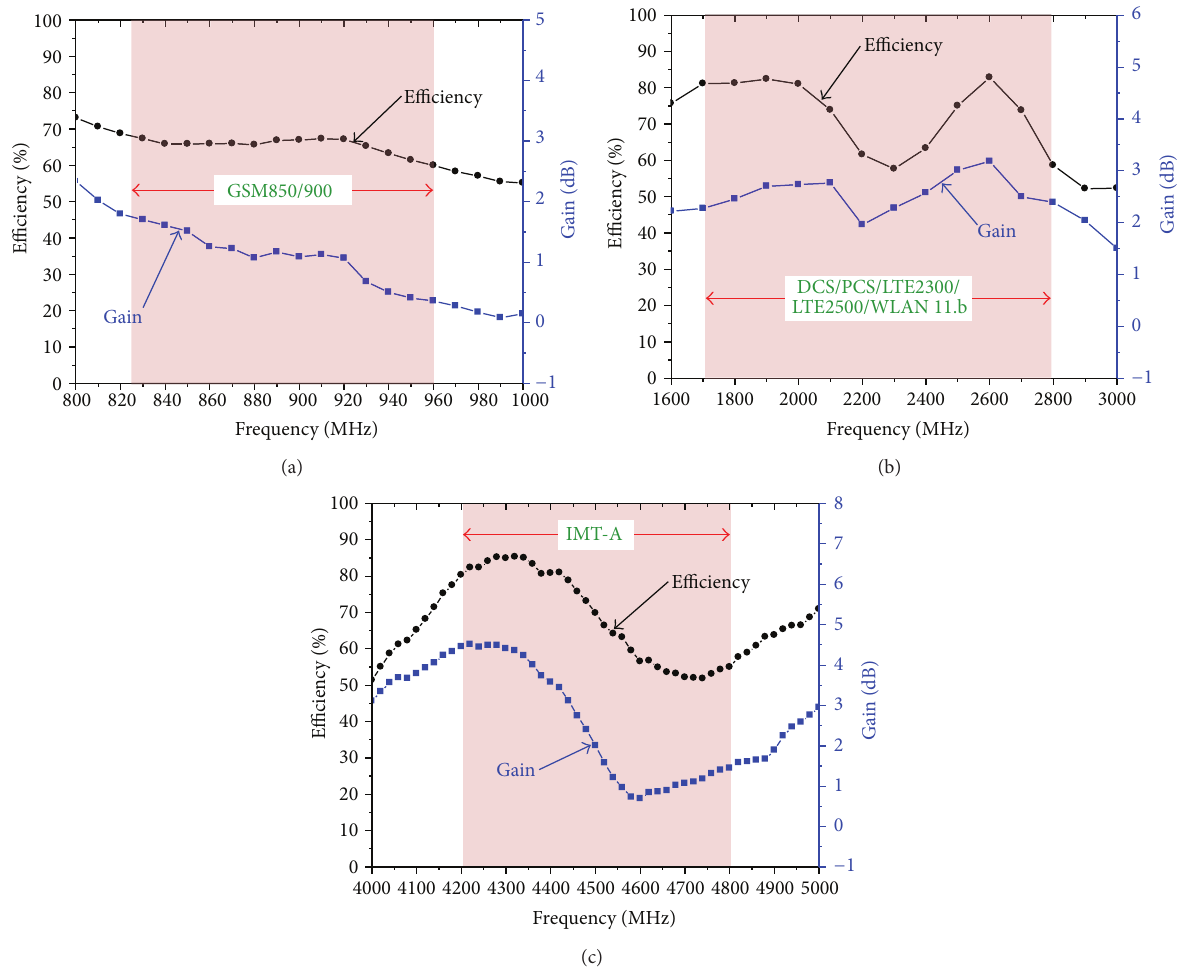
Figure 8: Measured antenna peak gain and radiation efficiency: (a) GSM850/900, (b) DCS1800/PCS1900/UMTS/WLAN 11.b/LTE2300/2500, and (c)